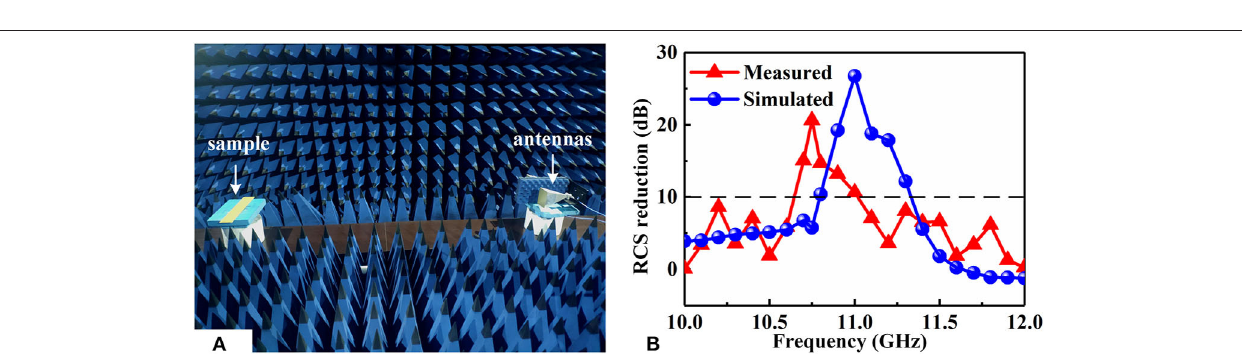
period length of 6 p , which is similar to the grating structure. The period length approximately corresponds to the wavelength of the operating frequency. The complete configuration